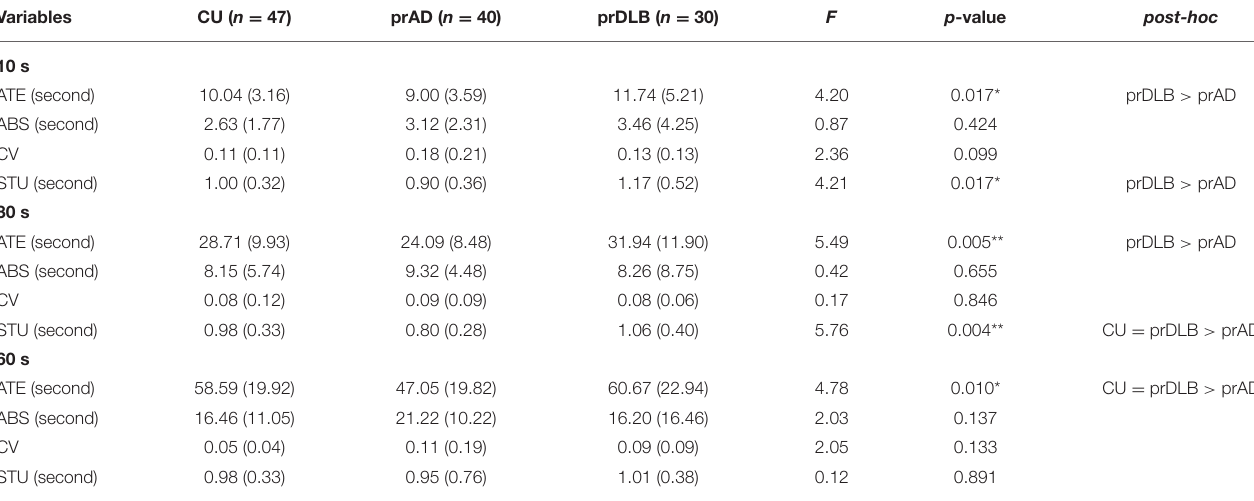
TABLE 4 | Time interval production test.